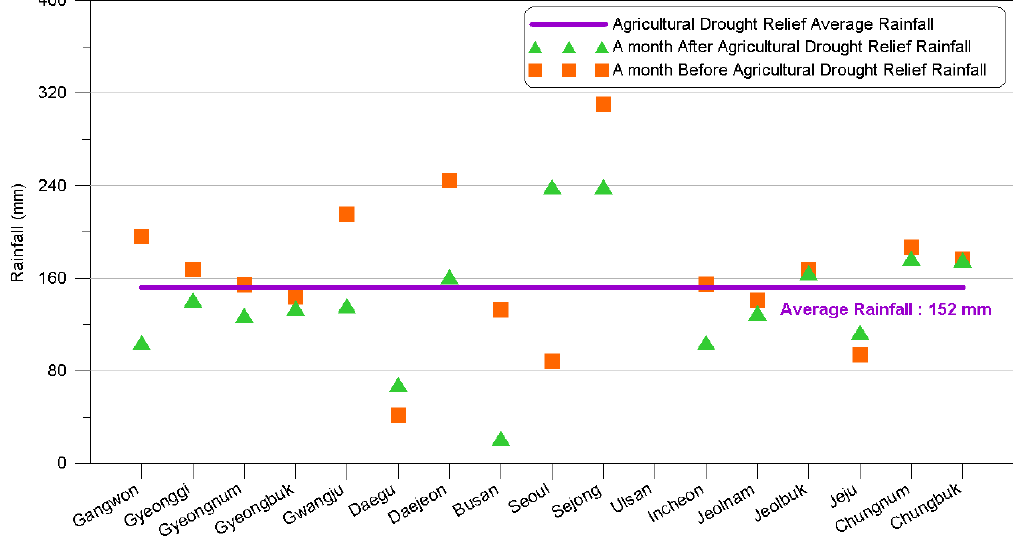
Figure 9. Setting up rainfall for disaster reduction relevant to agricultural droughts by municipality.